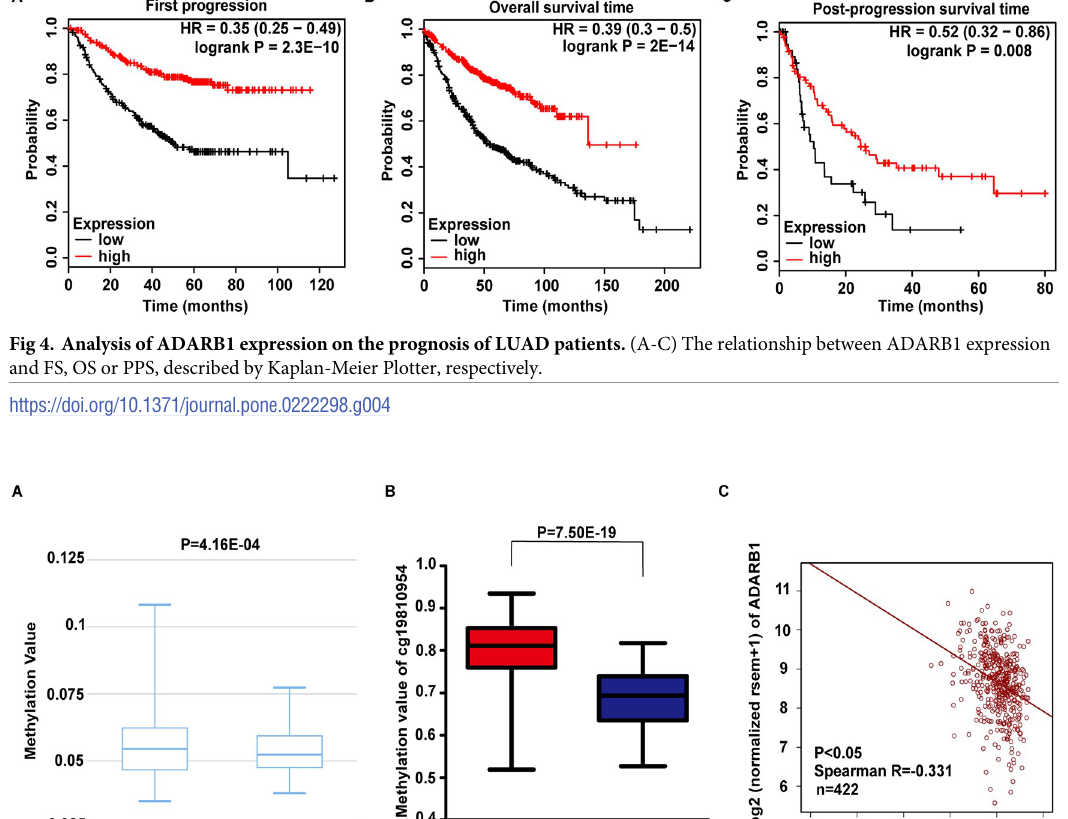
evaluate whether the effect of ADARB1 was through DNA methylation mechanism, we exam- ined cell migration capacity of Beas-2B and 95C cells under siADARB1 transfection and 5-azaD treatment. Compared to the non-treatment group, lung cancer cells showed a signifi- cantly lower migration distance when treated with inhibitors 5-azaD. Similar results were obtained after combinational treatment, and the promotion effects of siADARB1 were remark- ably decreased by 5-azaD treatment in Beas-2B and 95C cell lines (Fig 6E and 6F). These find- ing further supports the notion that promoting-cancer activity by ADARB1 inhibition is a consequence of the inhibition of DNA methylation signaling.